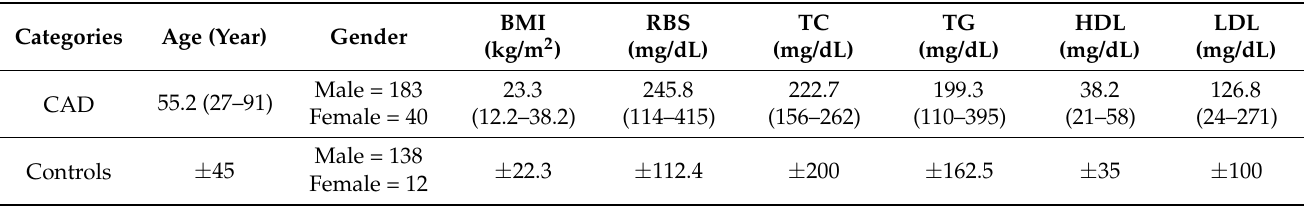
Table 1. Pre-clinical data about age, gender, BMI, RBS, TC, TG, HDL, and LDL of the CAD patients, as well as healthy